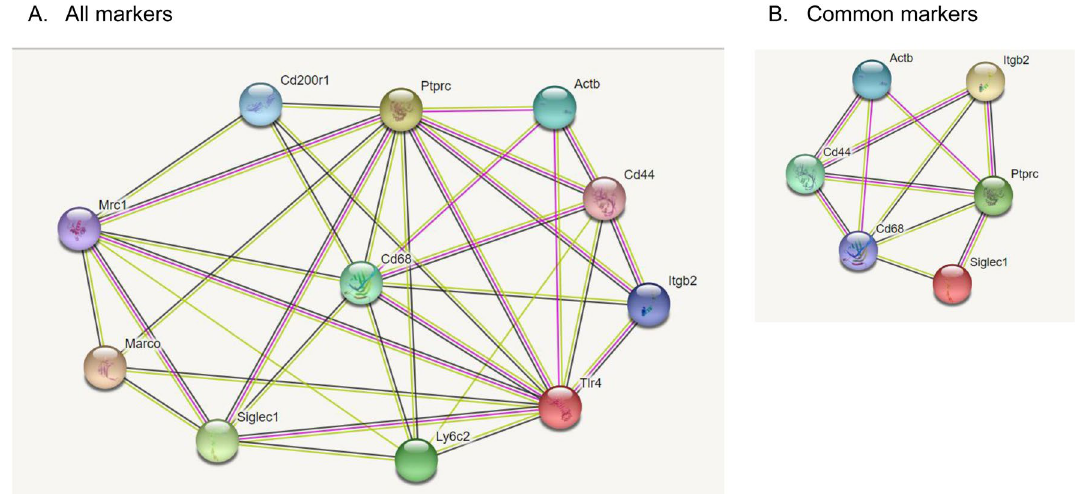
Figure 1. Interaction Diagrams. ( A ) used the gene names for the markers (with the exception of Marker 0 (cellular autofluorescence), which were entered into the String database (string-db.org) to generate an interaction diagram. The gene name for β-actin (actb) was used as a surrogate for phalloidin. ( B ) We entered 6 markers found in common in both this study and a similar study 29 involving male mice (indicated by ( ★ )) to generate a similar